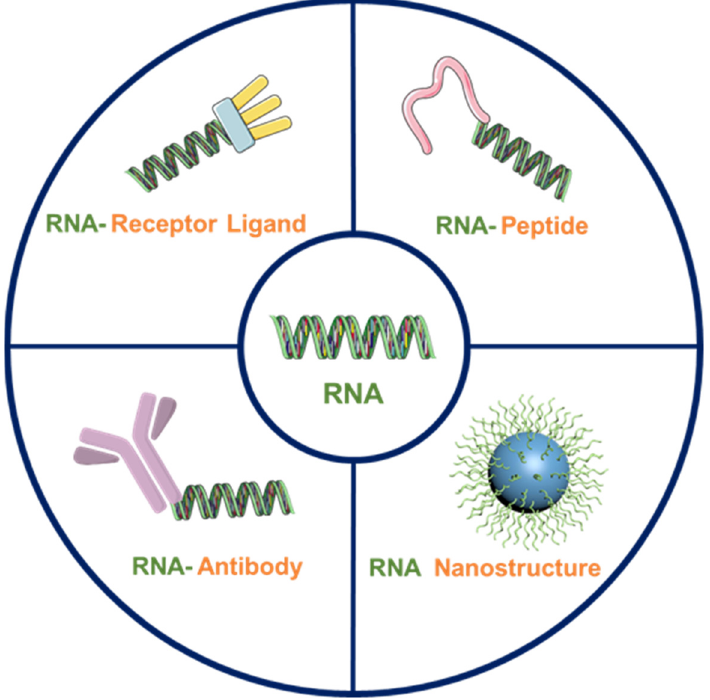
Figure 3. RNAs are modified with 4 types of junction molecules to form RNA-X conjugates.